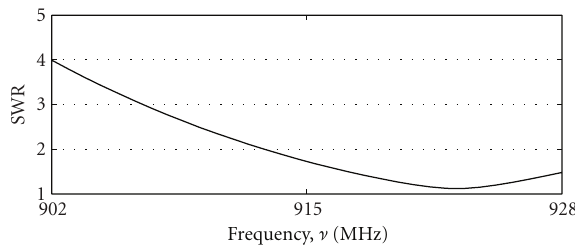
Figure 2: Optimal standing wave ratio behavior inside frequency range for multiobjective formulation.